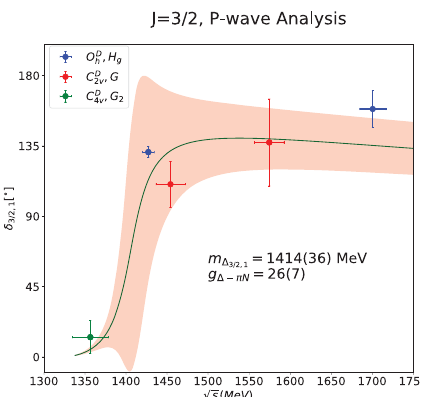
Figure 11. P -wave N π scattering phase shift against center-of- mass energy showing the Δ resonance where the cot δ 1 crosses zero. Results are from Ref. [15].